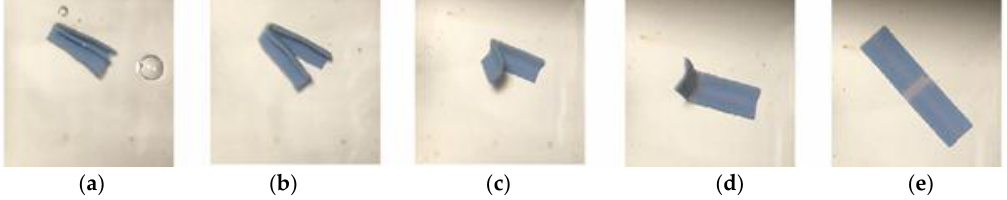
Figure 16. Method 2—the sequence of unfolding for 0.5 mm sample. ( a ) Unfold along folding line 1; ( b ) Continues to unfold; ( c ) Unfold along folding line 1 and unfold along folding line 2; ( d ) Continue to unfold along both folding lines; ( e ) Fully unfolded specimen.